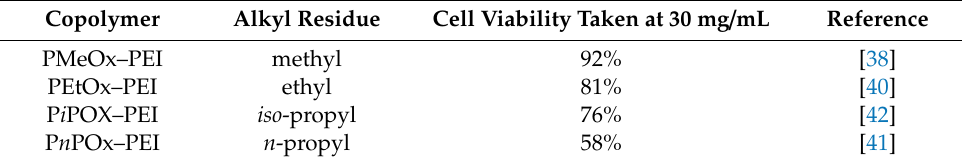
Table 3. Cell viability variations determined by MTT dye reduction assay for POx–PEI copolymers differing by their alkyl substituents. The copolymers are selected to be comparable by DP ( ≈ 70) and DH ( ≈ 15%).